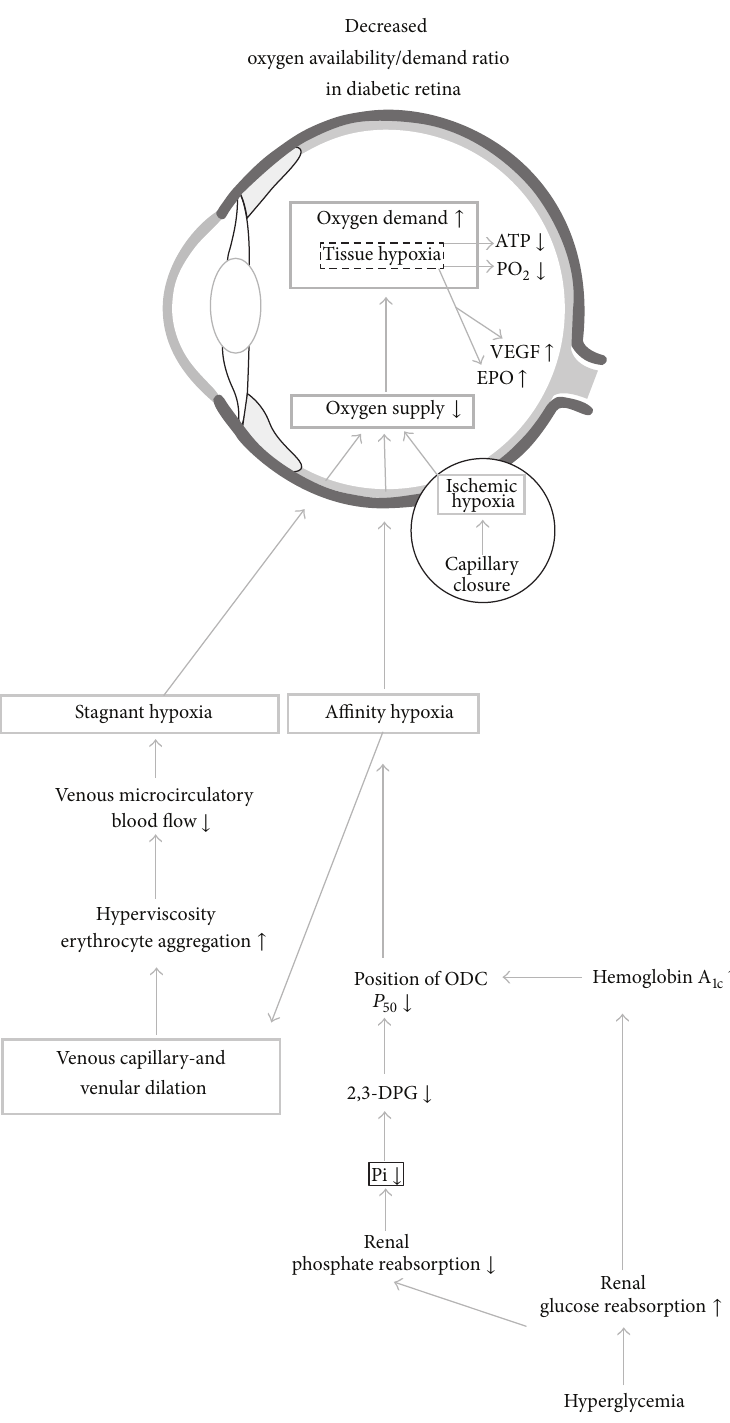
Figure 2: Flow chart of decreased oxygen availability/demand ratio in the diabetic retina. Hyperglycemia (lower right corner) leads to the withincreasedbindingofoxygencomparedwithhemoglobinA.This,combinedwithhypophosphatemia,leadstoaffinity formationofHbA 1 C hypoxia with decreased oxygen delivery to the venous part of the microvasculature, resulting in loss of tone in venous capillaries and venules. The resultant sluggish flow and decreased shear rate, erythrocyte aggregation, and blood viscosity (caused by increased plasma fibrinogen and alpha 2 -globulin) lead to venous microcirculatory stasis and stagnant hypoxia. Because retina has a high oxygen demand, tissue hypoxia leads to secretion of vascular endothelium growth factor (VEGF), erythropoietin (EPO), and possibly other growth factors. Capillary closure and ischemic hypoxia lead to further secretion of VEGF and other growth factors (see